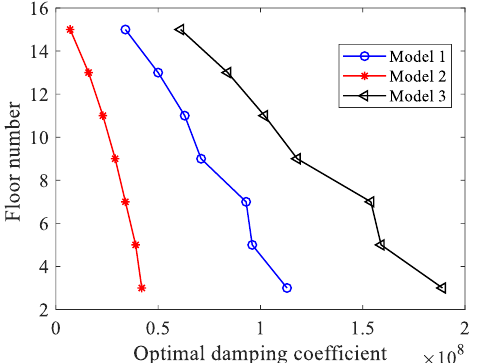
Figure 8. Optimal parameters versus position of the damping layer.